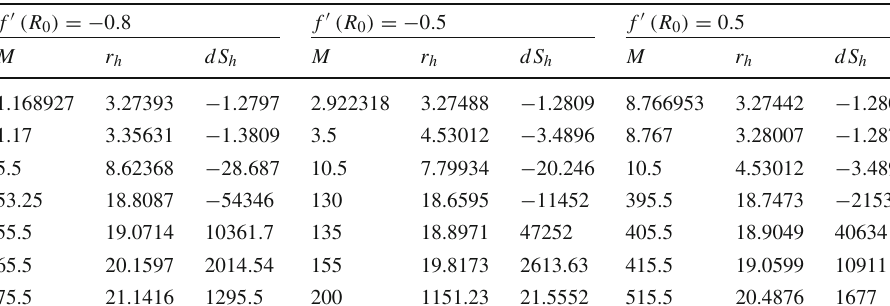
Table 5 The relation between dS h , M and r h of p =